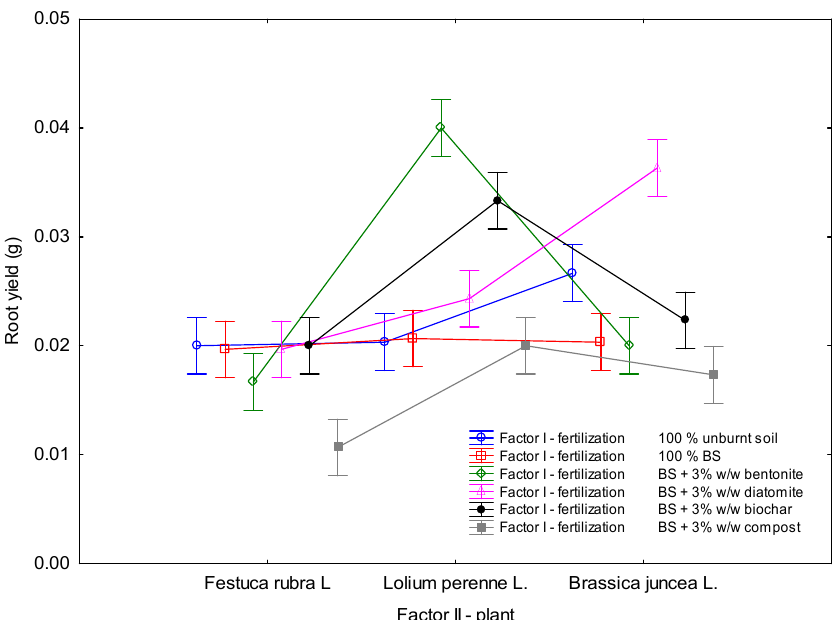
Figure A1. Graphical illustration of the effect of individual factors on the aboveground biomass yield.